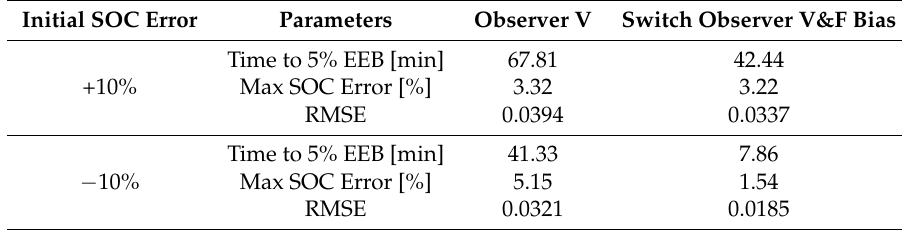
Table 3. Comparison of the RMSE index for different initial estimate error and different sensors using the simulated data. V, terminal voltage; V&F Bias, fusion of both sensors with bias